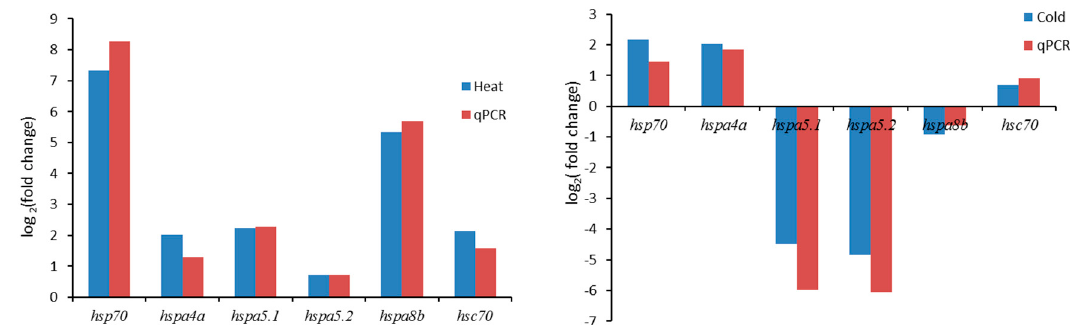
Figure 6. Validation of six significantly differential expressed genes by quantitative polymerase chain reaction (qPCR).